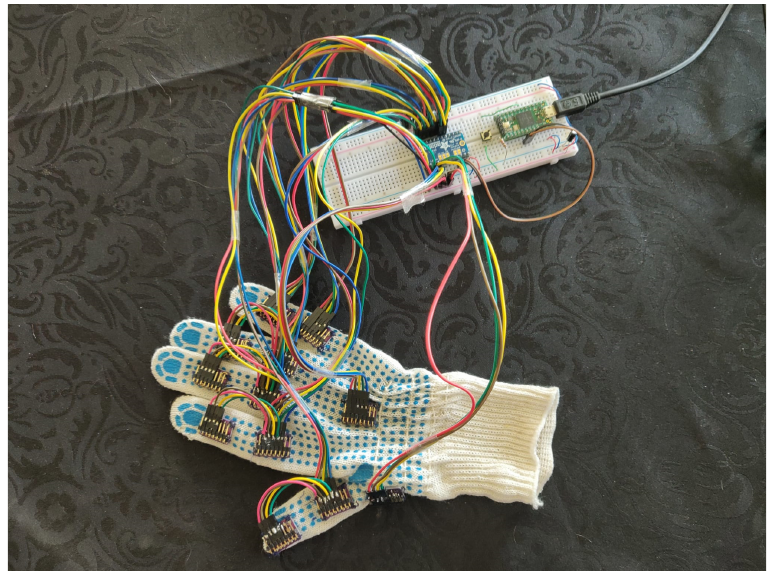
Figure 9. Second glove design with cascading